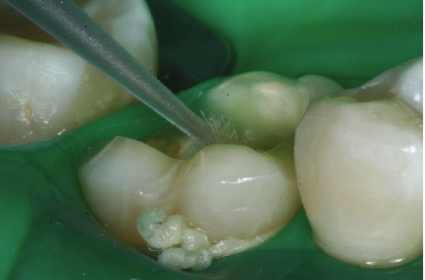
Figure 7: A conventional adhesive system (RelyX ARC) was used to bond the endocrown to the prepared